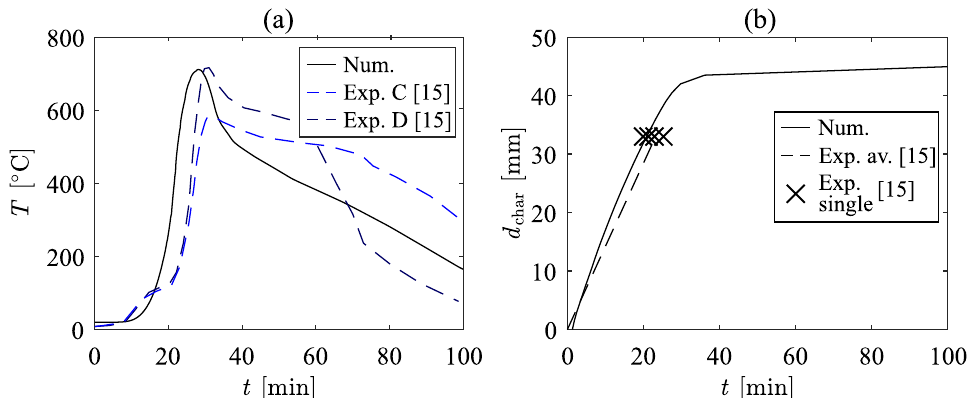
Fig. 11 Fire scenario 1. a The development of temperatures at the interlayer between first and second lamella. b The development of charring